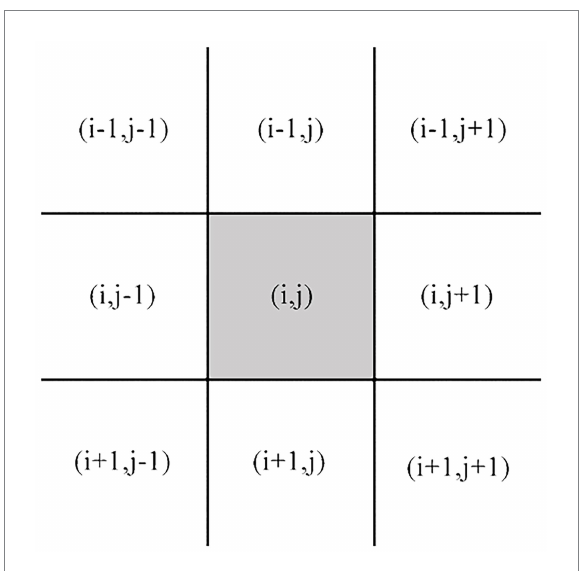
FIGURE 4 The image block Ω of eight neighborhoods that center on the pixel ( ( ) , i j . ( ) , x y ∈Ω